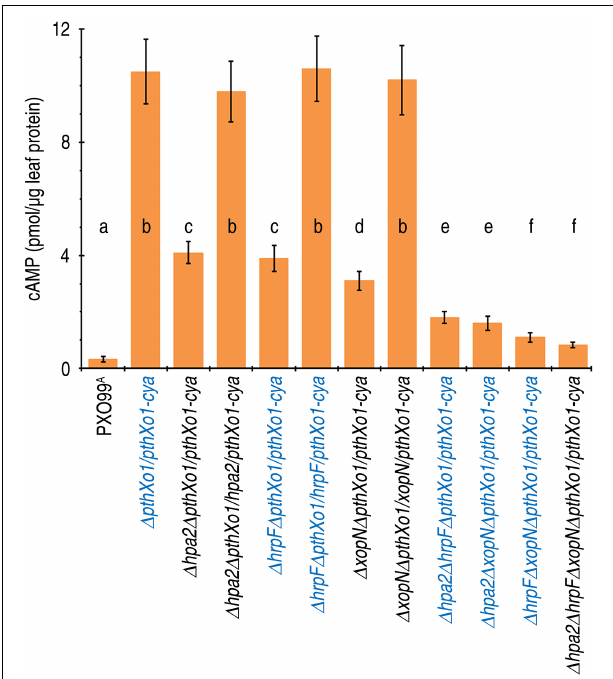
FIGURE 5 | The cooperative effects of hpa1 , hpa2 , and hrpF on PthXo1 translocation levels quantified as cytoplasmic cAMP concentrations in rice leaves. Leaves of 14-day-old Nipponbare rice seedlings were inoculated by infiltration with bacterial suspensions of PXO99 A and hpa1 , hpa2 , and hrpF single, double, and triple mutants, respectively. 12 h later, inoculated leaves were excised and used in measurements of cytoplasmic cAMP concentrations. Data shown are the mean values ± SDs. Different letters on bar graphs indicate significant differences of data obtained from the plants inoculated with the different bacterial strains (ANOVA and Duncan’s test, P < 0.001, n = 3 independent experiment each involving 30 leaves of 15 plants).